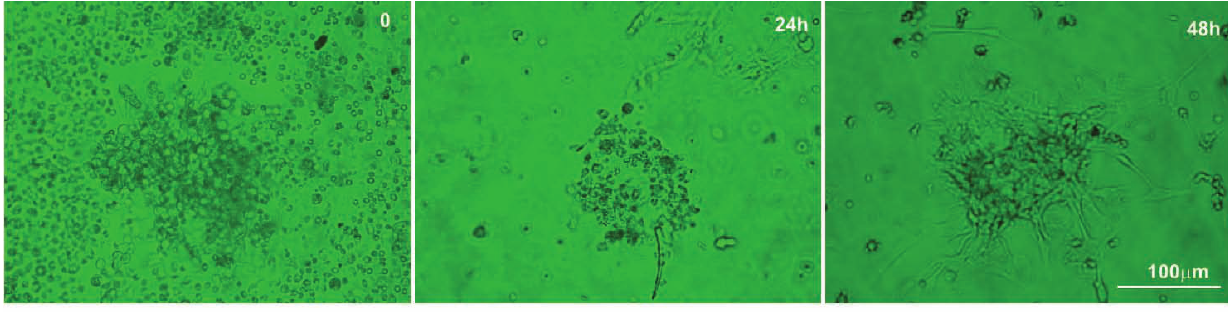
Figure 1. Primary cultures of cells harvested from an atrial myxoma excised from a symptomatic, 75-years-old-male patient. After col- lagenase Type II digestion, cells spontaneously formed aggregates and attached to a cell culture dish. Erythrocyte contamination was observed (0). On the first day of culturing, cells started to spread over the surface (24 h). After 48 h the cells presented their migrato- ry phenotype.